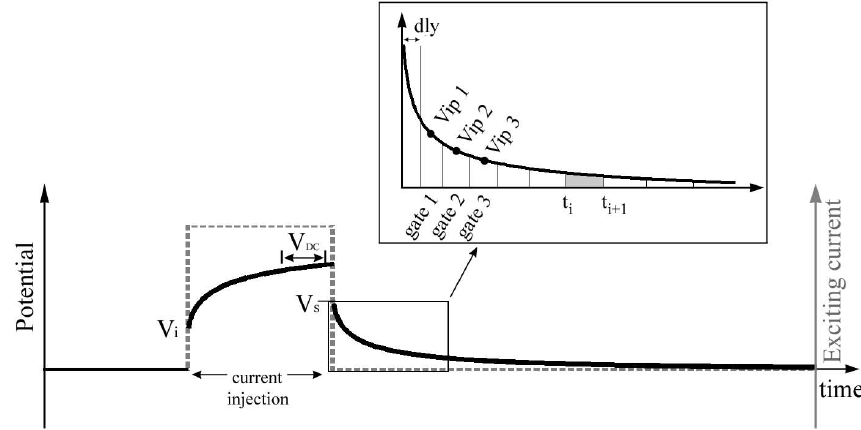
Fig. 4. Basic principles of time domain IP acquisition. The figure shows a sketch of the exciting current and the resulting voltage.